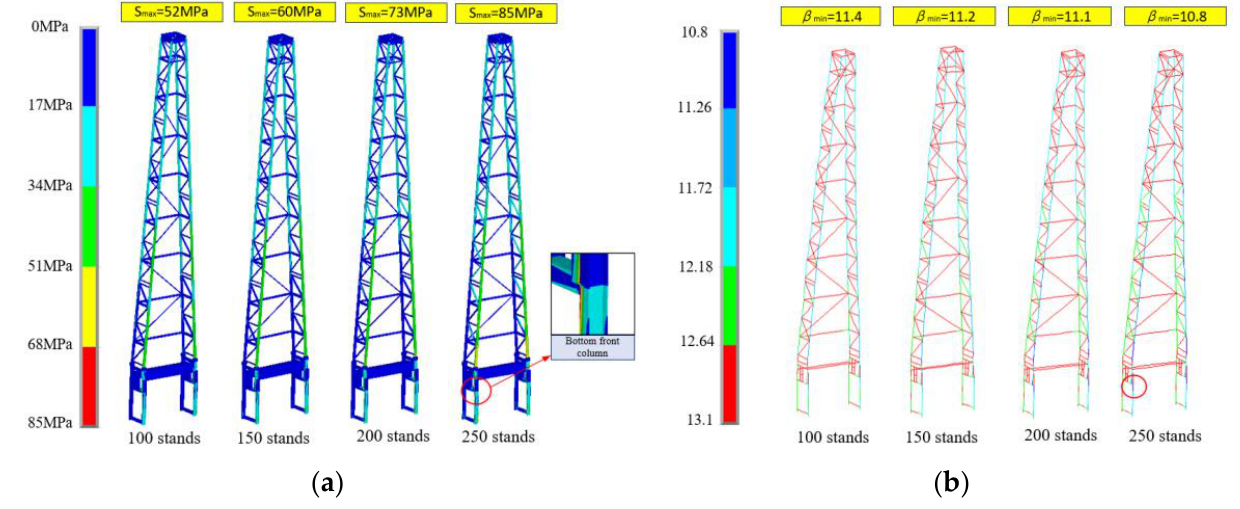
Figure 7. The variation of the stress and reliability index with increasing number of stands. ( a ) Stress contour plot. ( b ) Reliability index contour plot.